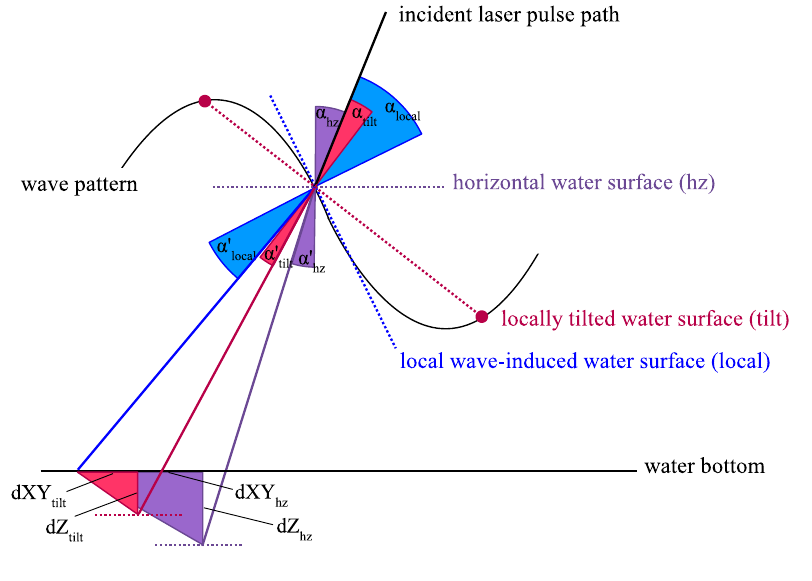
Figure 1. Refraction based on the true local water surface (blue), a assumed horizontal water surface (purple) and a assumed locally titled water surface (red) resulting in a lateral displacement dXY hz and dXY tilt and a height displacement dZ hz and dZ tilt